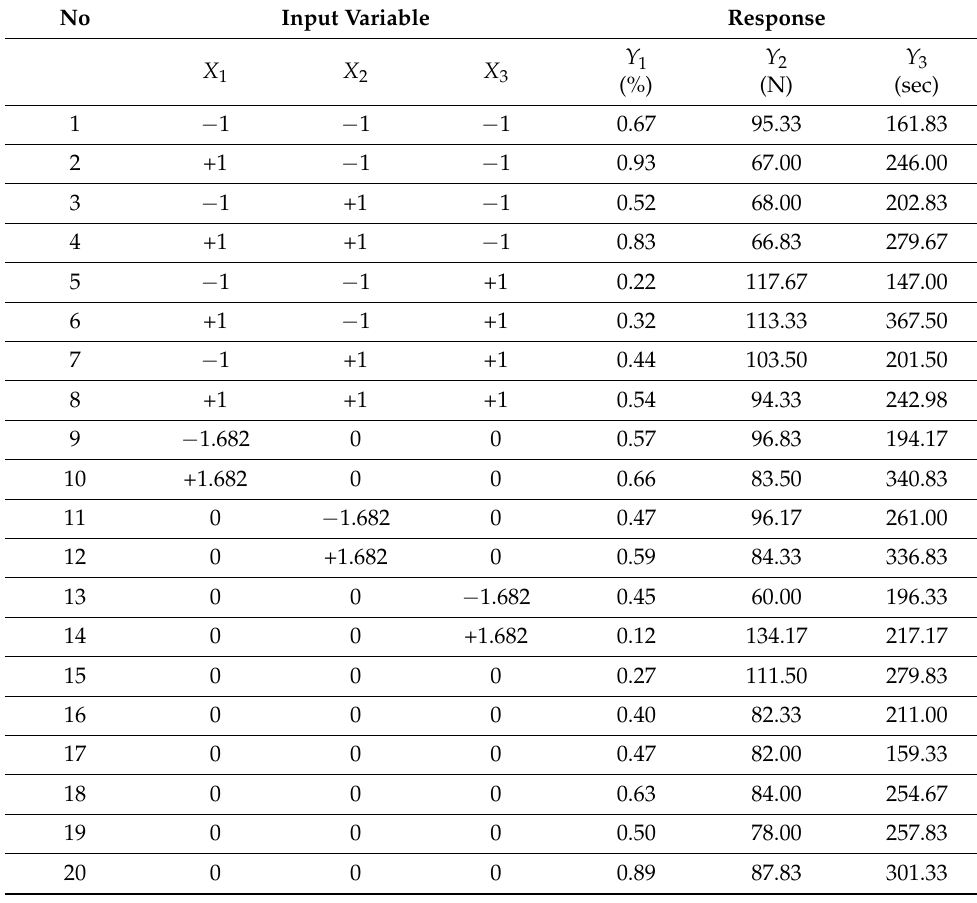
Table 3. Experiment Data Result using